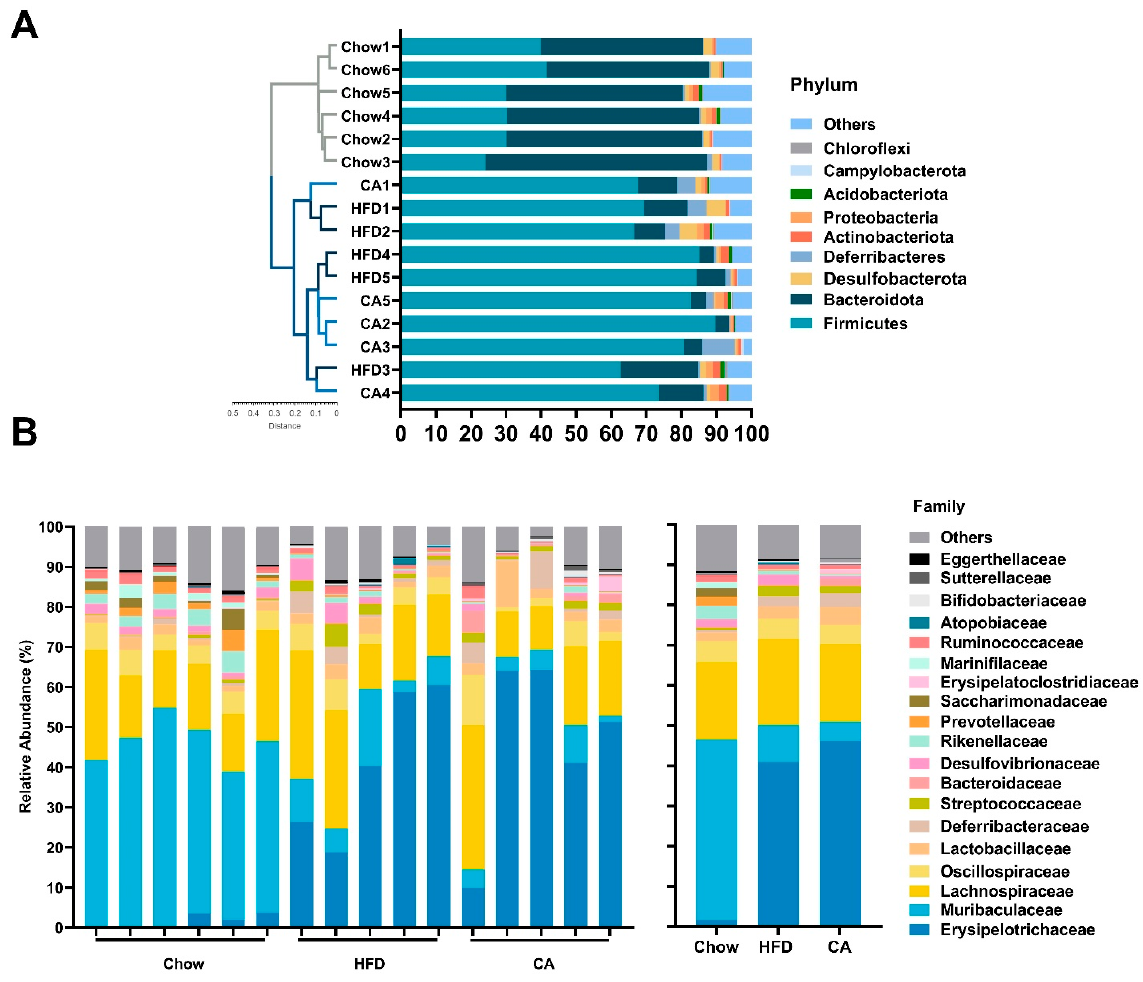
Figure 7. The composition of gut microbiota. ( A ) The relative abundance of the nine most abundant taxa at the phylum level; UPGMA with weighted UniFrac distance. ( B ) The relative abundance of the 19 most abundant taxa at the family level. Data are expressed as means ( n = 5–6).